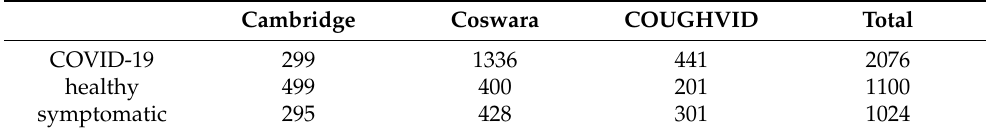
Table 1. Number of audio files before inspection.